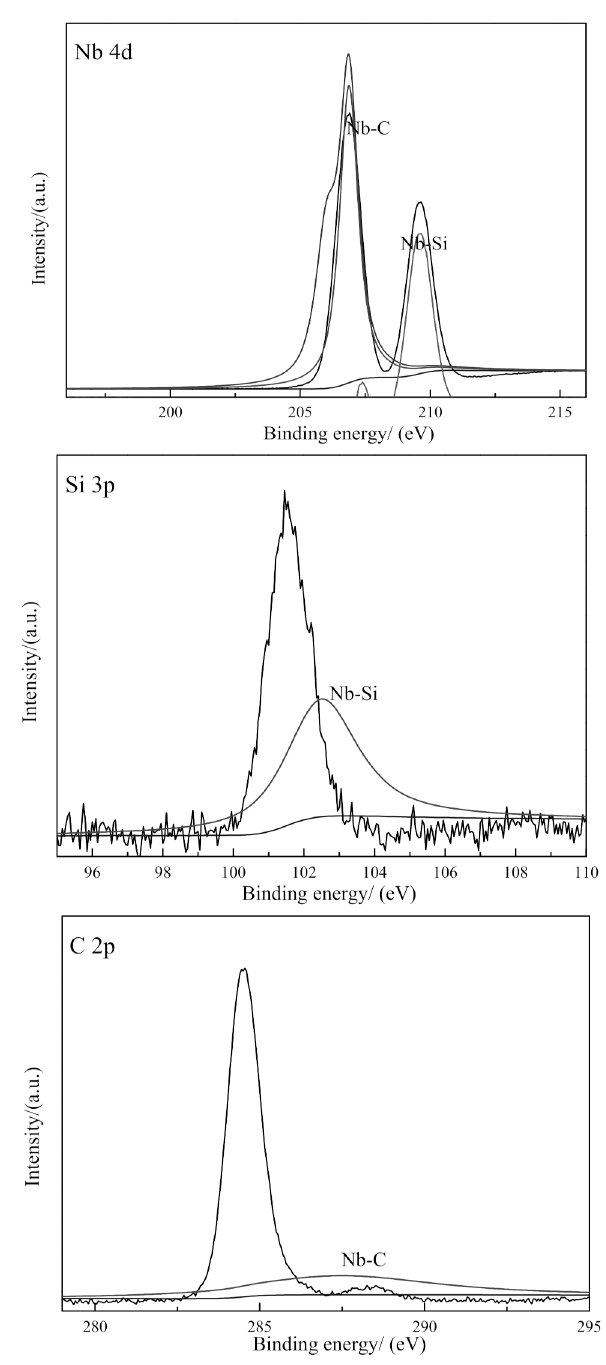
Figure 2. X-ray photoelectron spectroscopy for film